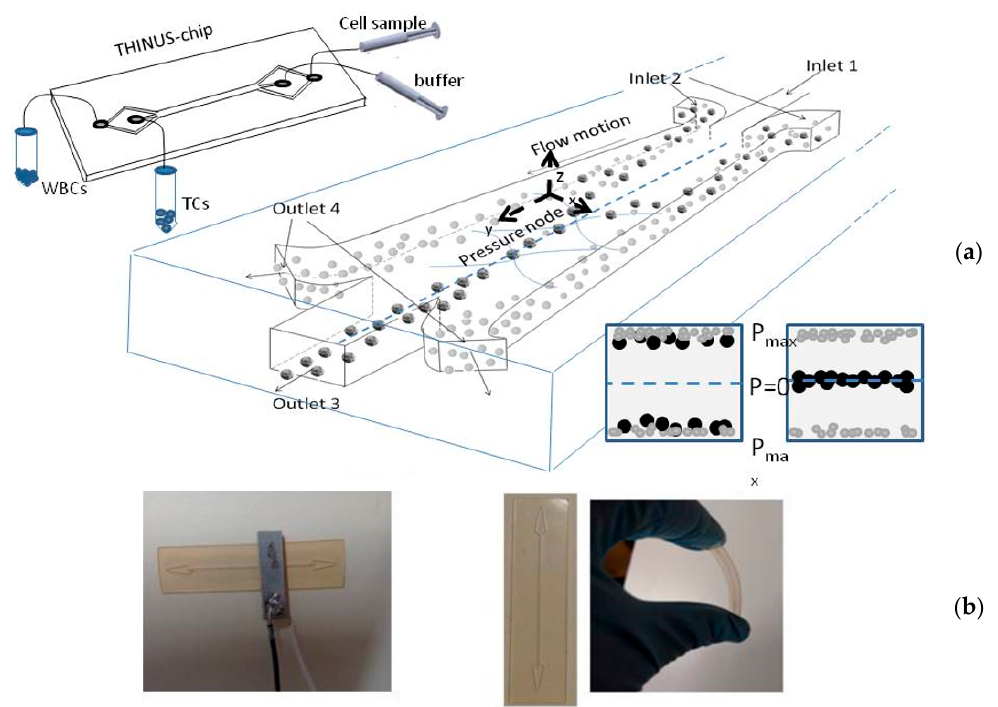
Figure 3. ( a ) A schematic view of the present cancer cell isolation THINUS-chip, with a collection of the bigger particles along the center of the channel, while the small particles continue their flow motion undisturbed by the acoustic field, and ( b ) the fabricated cancer cell isolation chip.